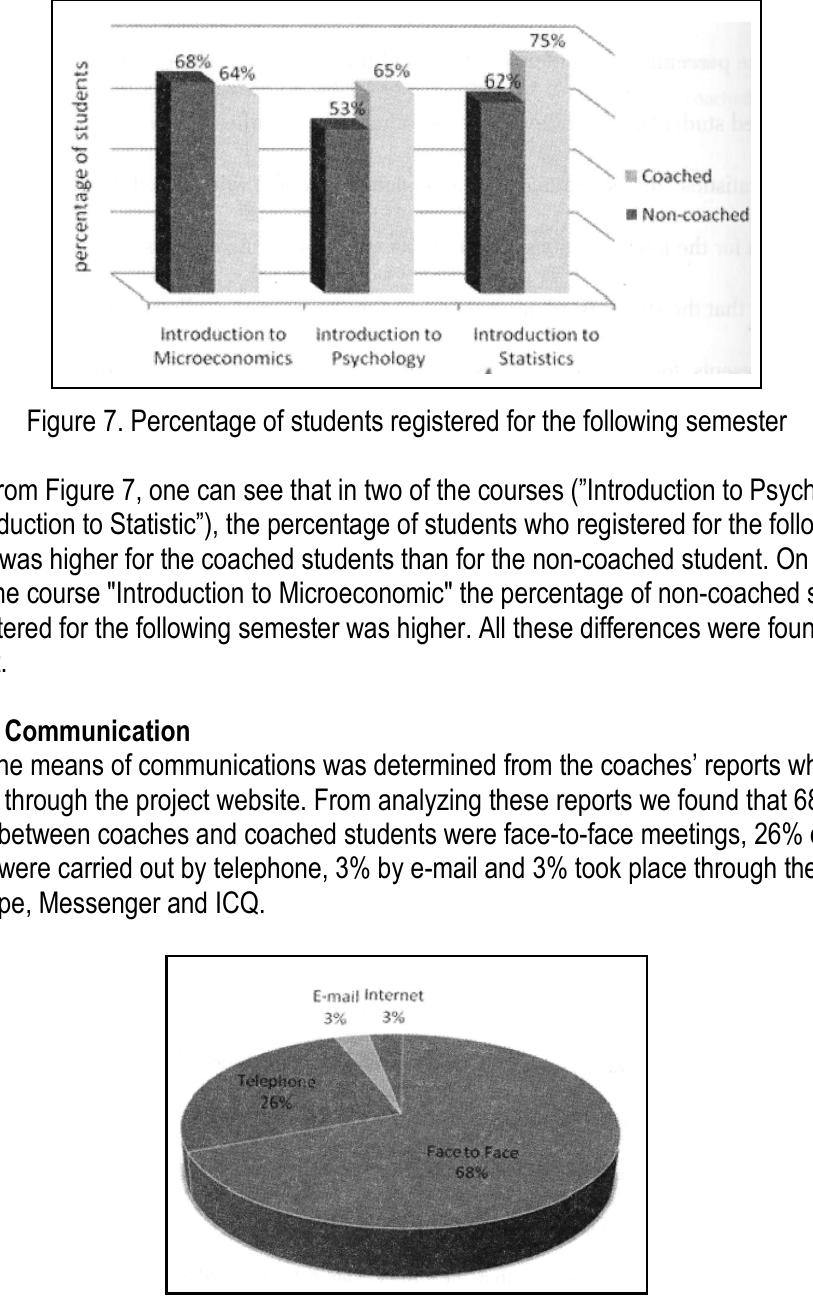
Figure 8. Means of students